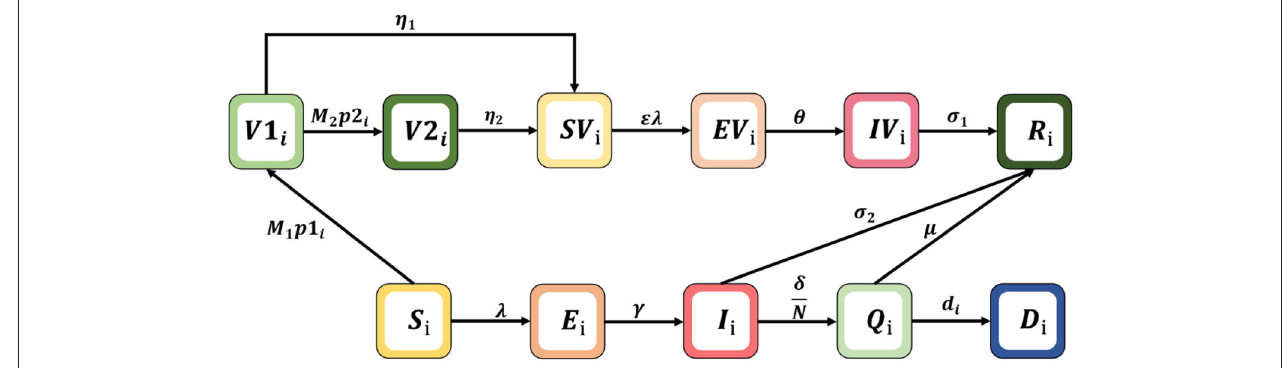
FIGURE 1 | Schematic diagram of the mathematical model.